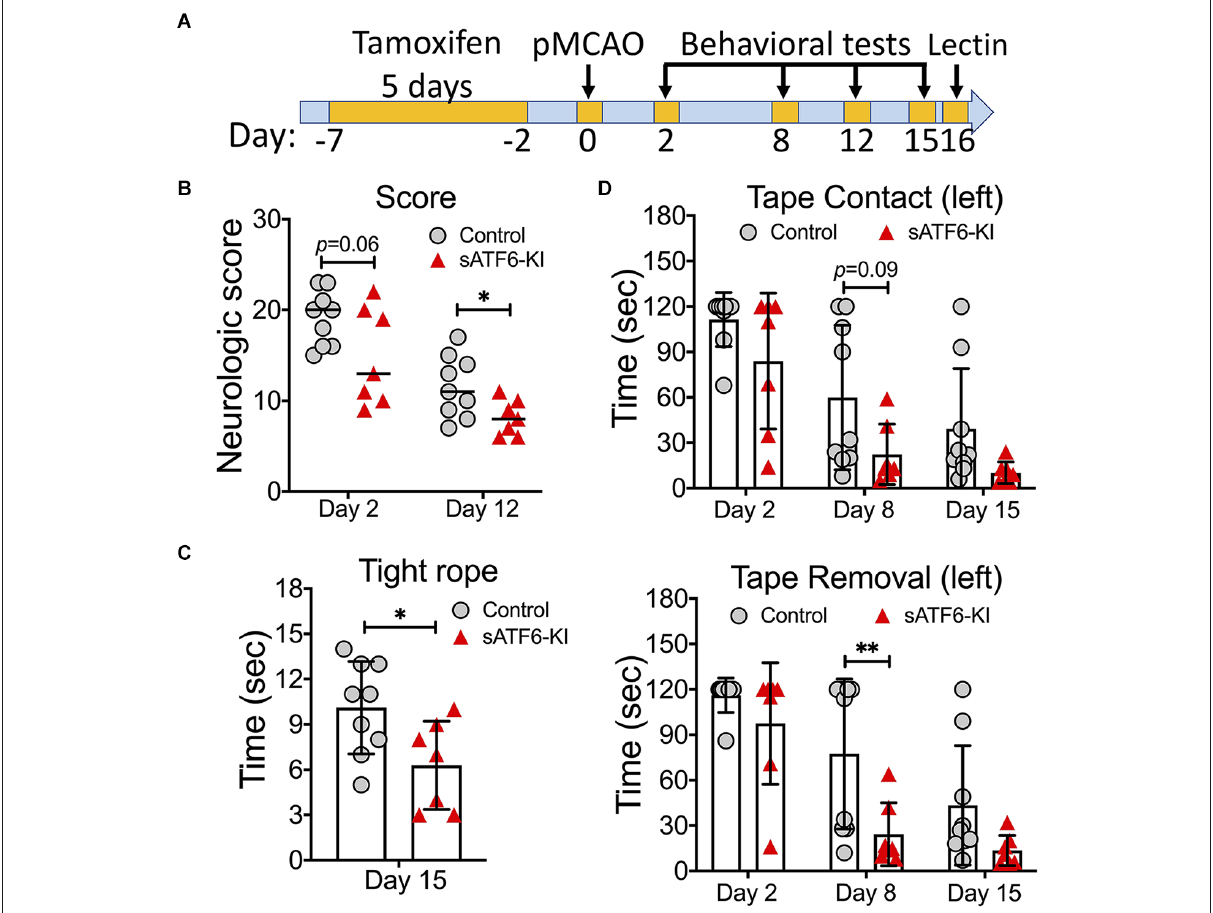
FIGURE3 Activation of the ATF6 pathway in neurons improved long-term outcome after permanent MCAO (pMCAO). (A) Experimental design. (B–D) Stroke outcome. sATF6-KI ( n = 7) and littermate control ( n = 9) mice were subjected to pMCAO. Of note, all mice received tamoxifen treatment every other day from 4 to 15 days after stroke behavioral tests, including neurologic scoring (B) , tight rope test (C) , and tape removal test (D) , were performed over 15 days after stroke. Data are presented as mean ± SD or median. ∗ p < 0.05; ∗∗ p <